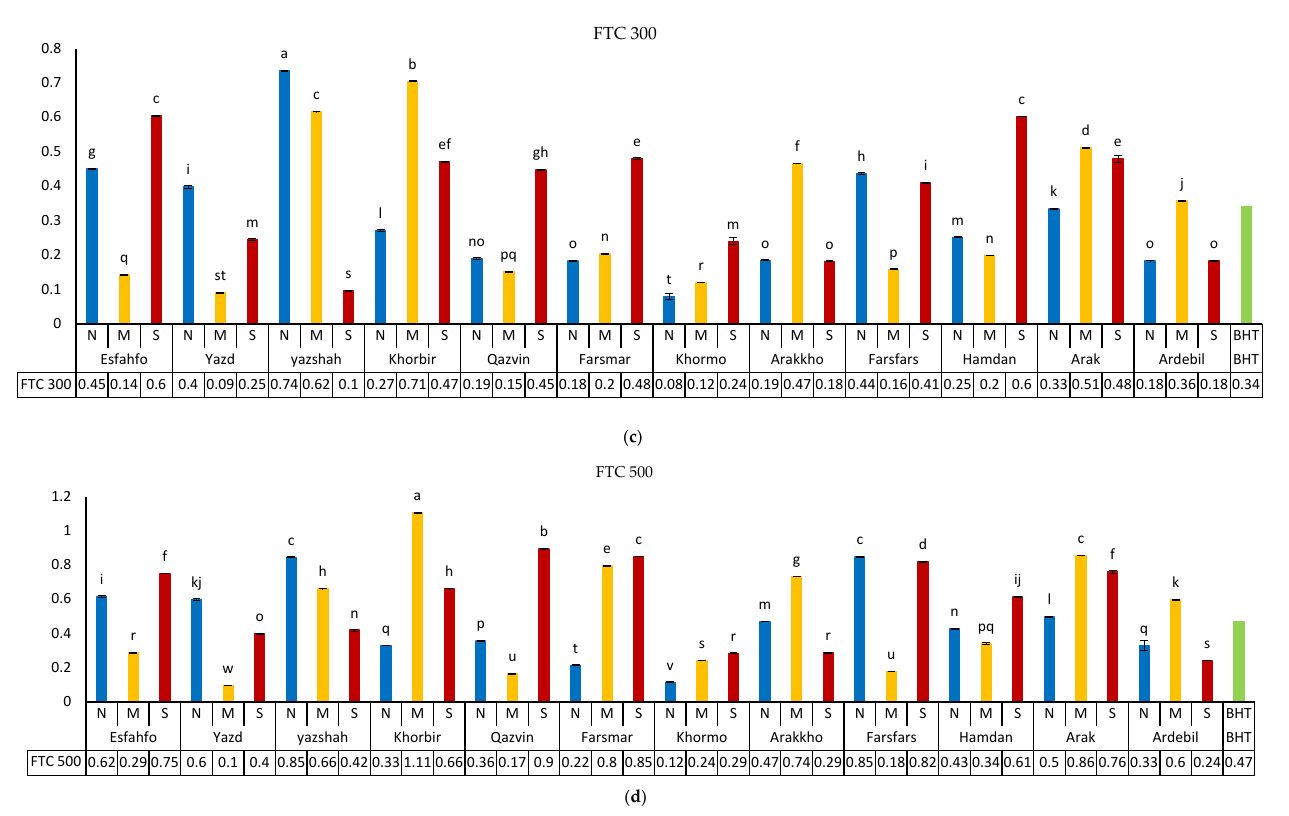
Figure 3. ( a ) Antioxidant capacity based on reducing power in 50 ppm conc. of 12 ajowan extracts as compared to BHT. (N) Normal, (M) moderate, and (S) severe drought conditions. ( b ) Antioxidant capacity based on reducing power in 100 ppm conc. of 12 ajowan extracts as compared to BHT. (N) Normal, (M) moderate, and (S) severe drought conditions. ( c ) Antioxidant capacity based on reducing power in 300 ppm conc. of 12 ajowan extracts as compared to BHT. (N) Normal, (M) moderate, and (S) severe drought conditions. ( d ) Antioxidant capacity based on reducing power in 500 ppm conc. of 12 ajowan extracts as compared to BHT. N) Normal, (M) moderate, and (S) severe drought conditions.